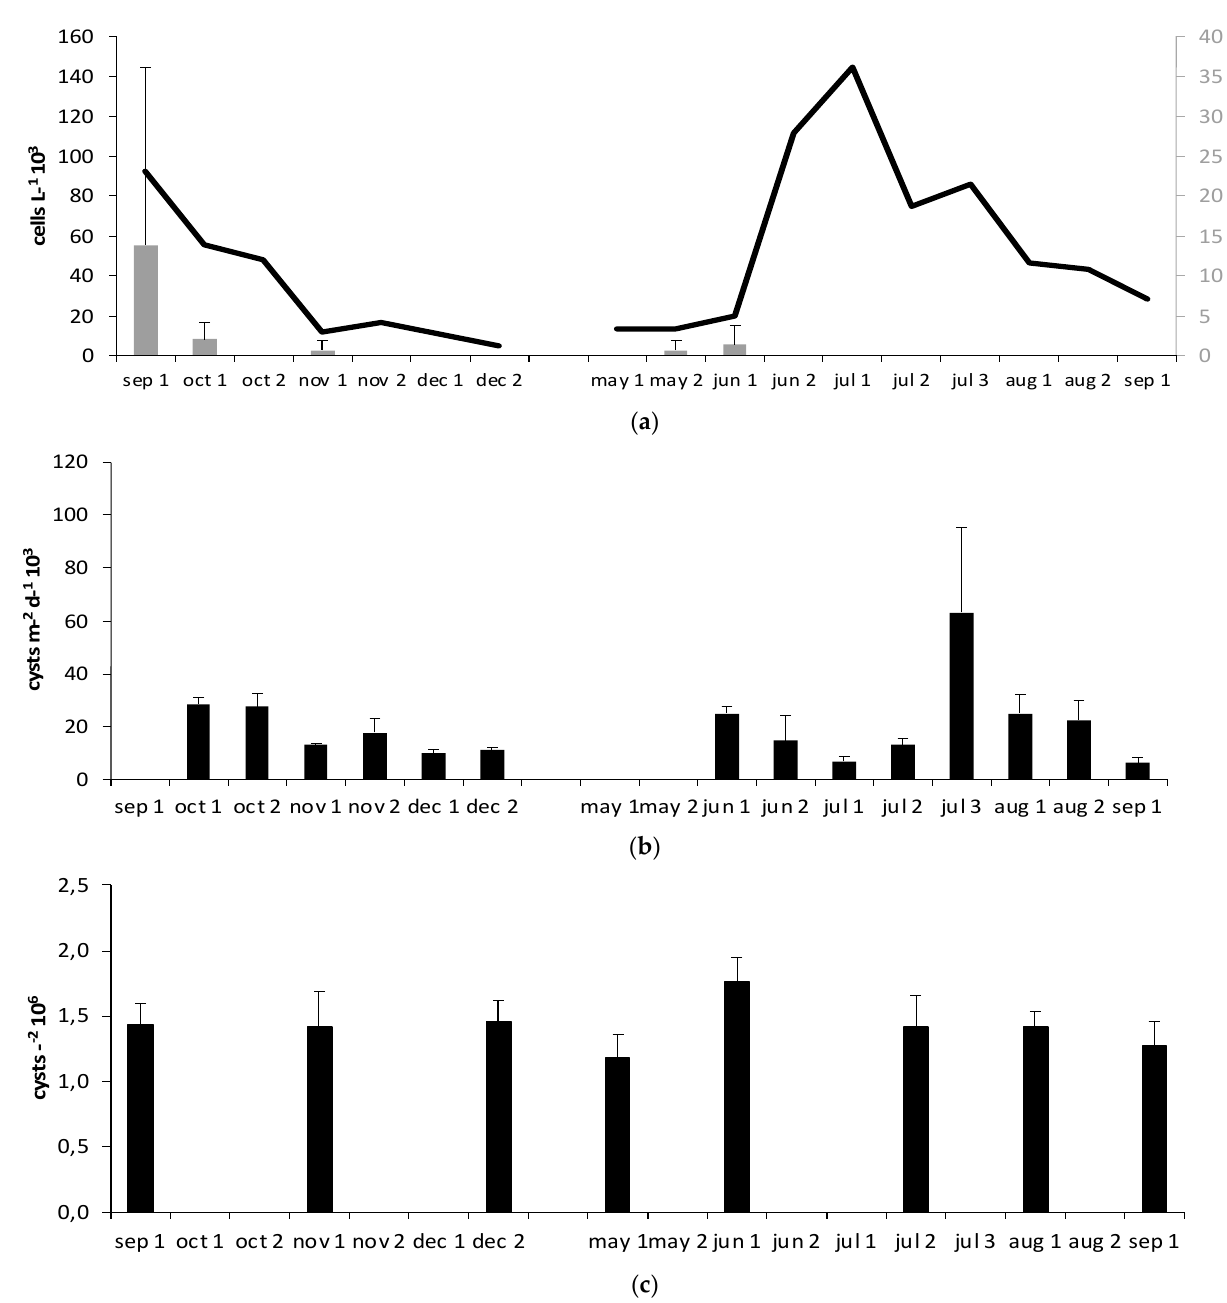
Figure 9. The benthic-pelagic dynamics of Scrippsiella acuminata in the Mar Piccolo of Taranto; ( a ) active cells in the water column, collected with a Niskin bottle at three different depths (black lin); active cells (intended as germinated) from the sediment, collected with inverted traps (grey bars); ( b ) cyst fluxes to the bottom, collected by sediment traps; ( c ) full cysts in surface sediment cores.